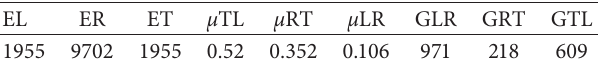
Table 2: Basic parameters of timber purlin